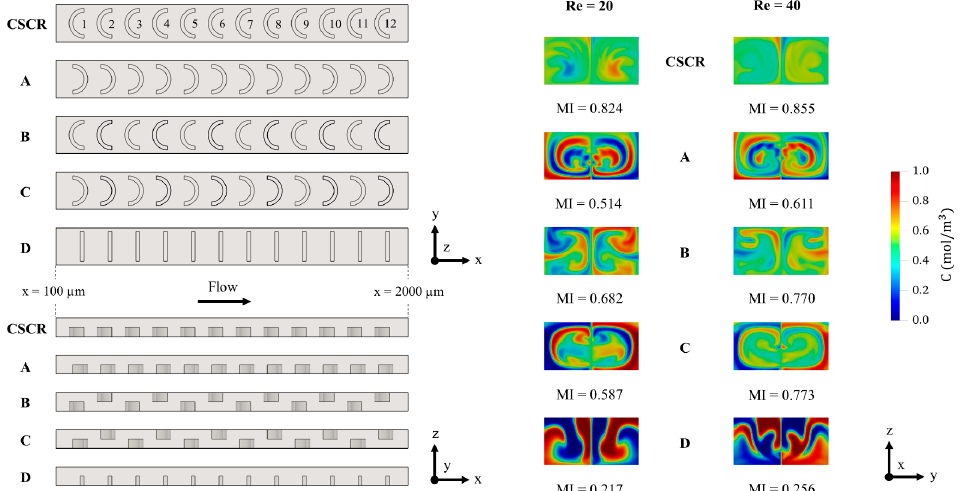
Figure 16. Alternative micromixer configurations with semi-circular (i.e., A, B, and C) and rectangular (i.e., D) ridges. Top and side views of the mixing channels (left). Outlet concentration distributions at Re = 20 and 40 for corresponding micromixer configurations (right).